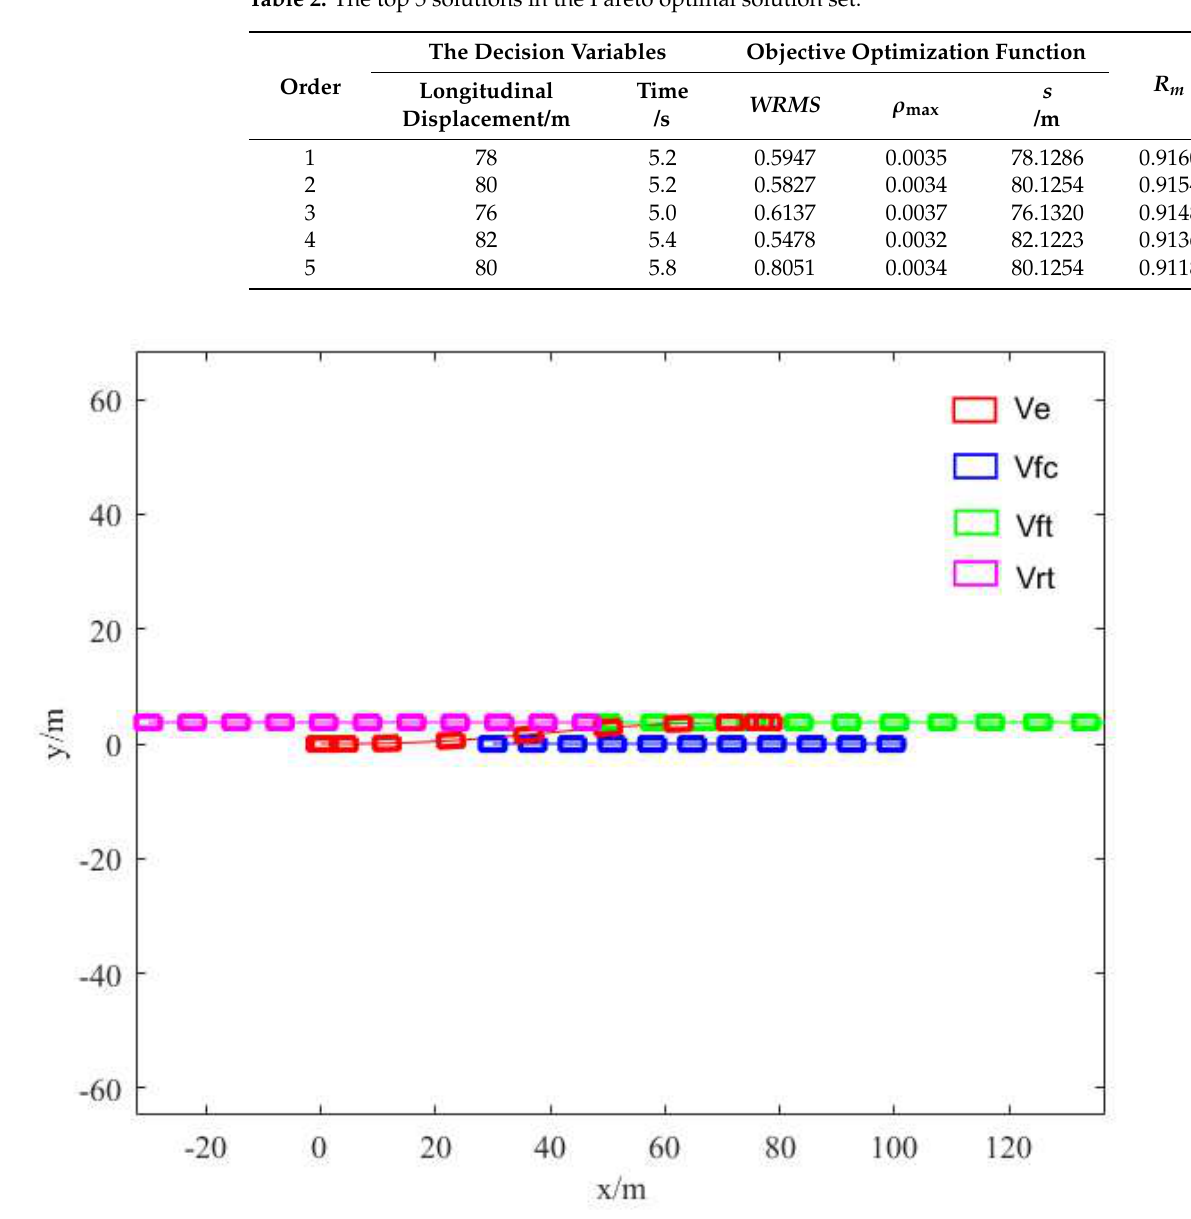
Table 2. The top 5 solutions in the Pareto optimal solution set.